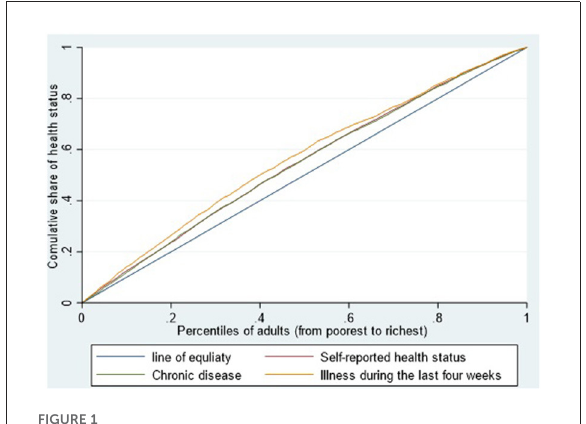
FIGURE1 The concentration curve of health status among Chinese western rural adults in 2014 (N =